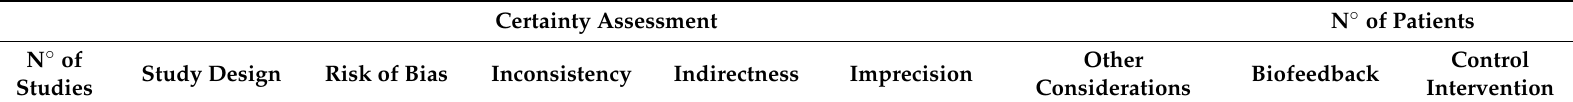
Other Control Absolute Biofeedback Considerations Intervention (95%